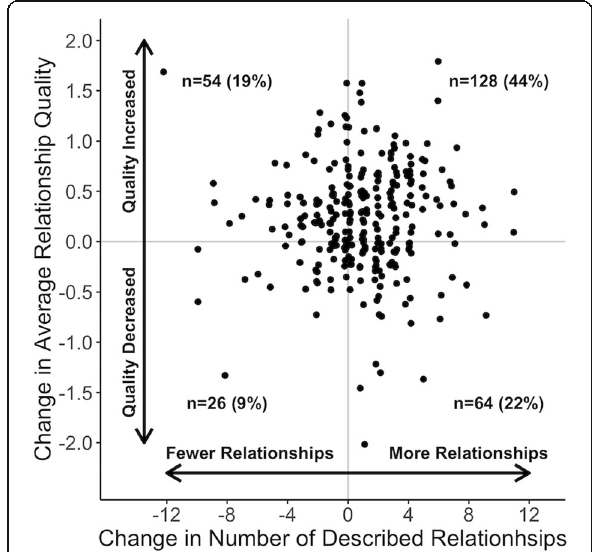
Fig. 4 Change in size and quality of student-generated conceptual models from a pre-lesson to post-lesson activity. Size was quantified as number of labeled arrows (relationships) that could be scored for the quality of the description. Quality for each relationship in a student model was assessed on an incorrect (1), vague (2), and technically correct (3) score and the change represented the change in average model score per student from pre to post